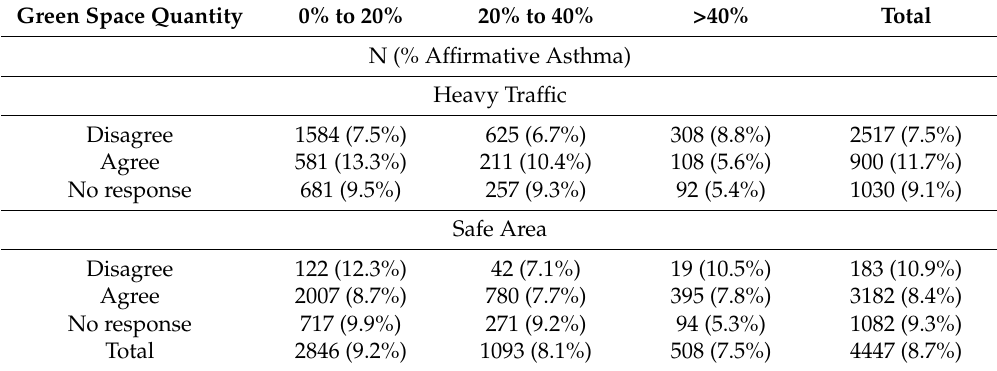
Table 1. Cross-tabulation of the study sample and prevalence of affirmative asthma with respect to green space quantity and parental perception of heavy